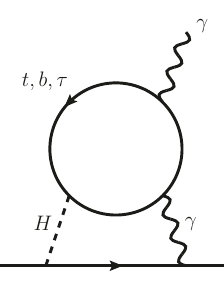
Figure 1 . Two-loop level contribution (so-called Barr-Zee type diagram) to the electron EDM in extended Higgs models with nonstandard Yukawa